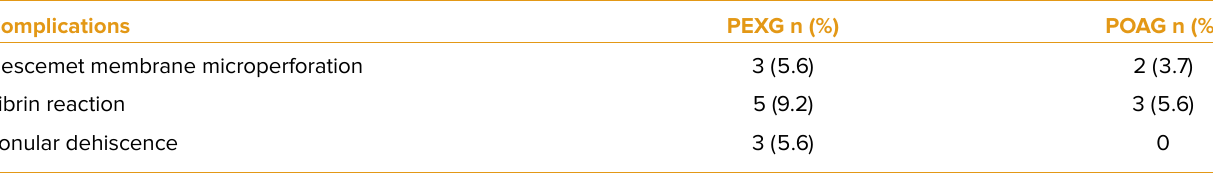
Table 3. Intraoperative and postoperative complications Complications